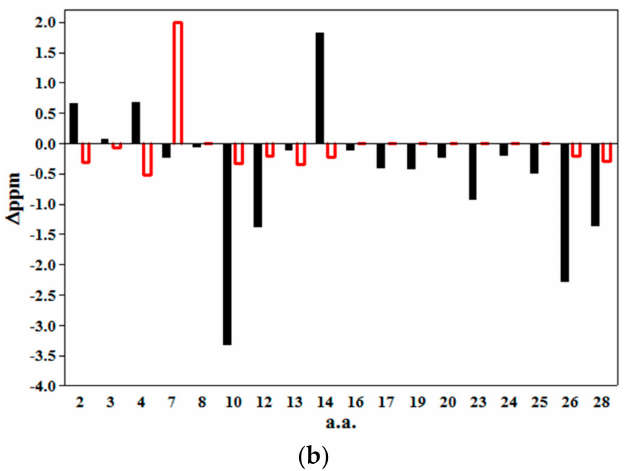
Figure 6. Bar graphs of Chemical shift difference between amide resonances of T α 1 in presence of PC-PS vesicles (black) and in presence of HA at a concentration of 0.4% ( w / w ) (red) ( a ); chemical shifts of amide proton and ( b ) chemical shifts of amide